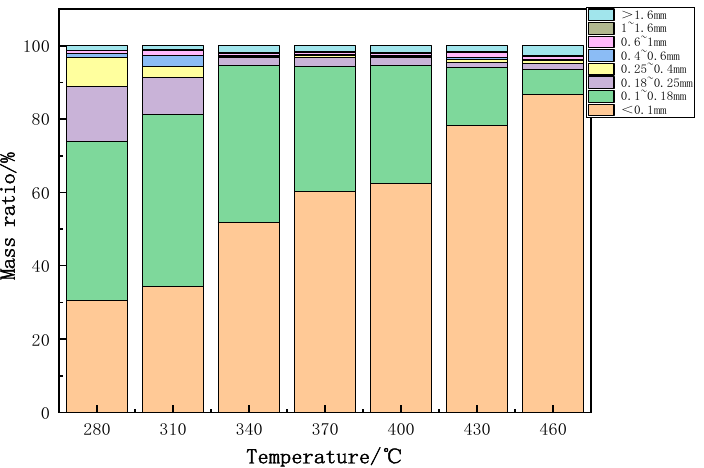
Figure 5. Particle size distribution of crushed PVC film heated at different temperatures.